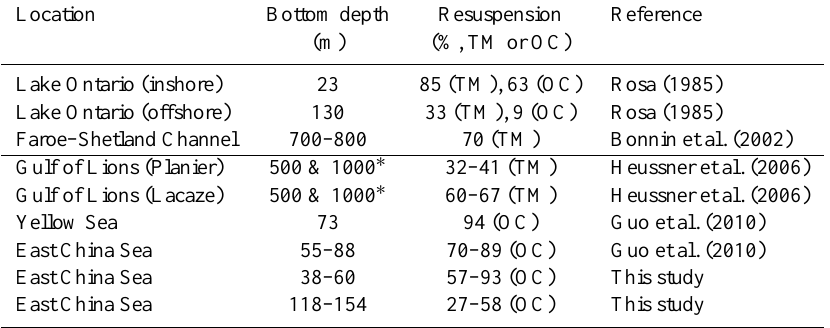
Table 6. Estimated resuspension of total trapped mater or organic carbon collected by sediment traps in different regions. Location Bottom